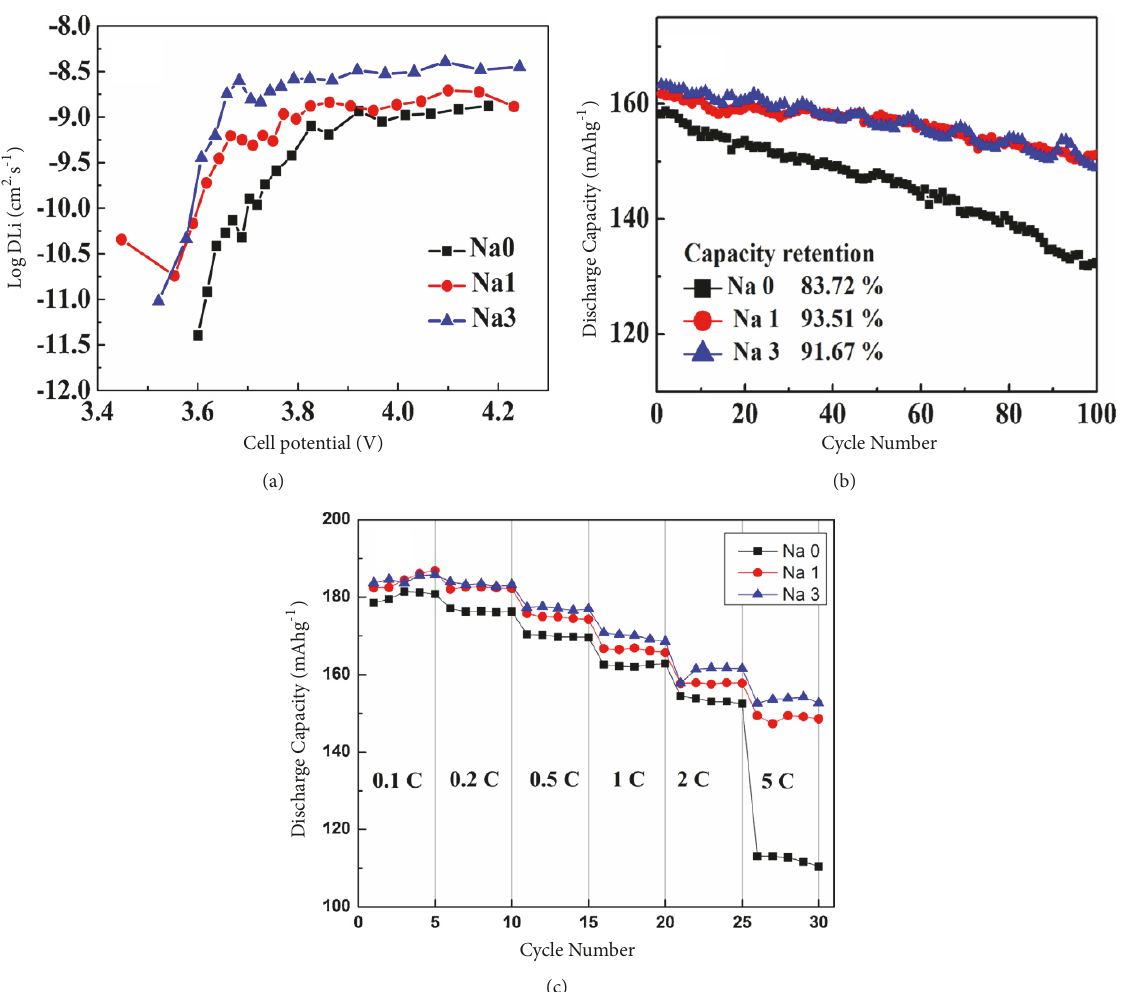
Figure 9: (a) Li + diffusion coefficient, (b) cyclic performance at 160mAg −1 , and (c) rate capability of Na + doped-NCM622 [50]. Copyright: Electrochimica Acta,